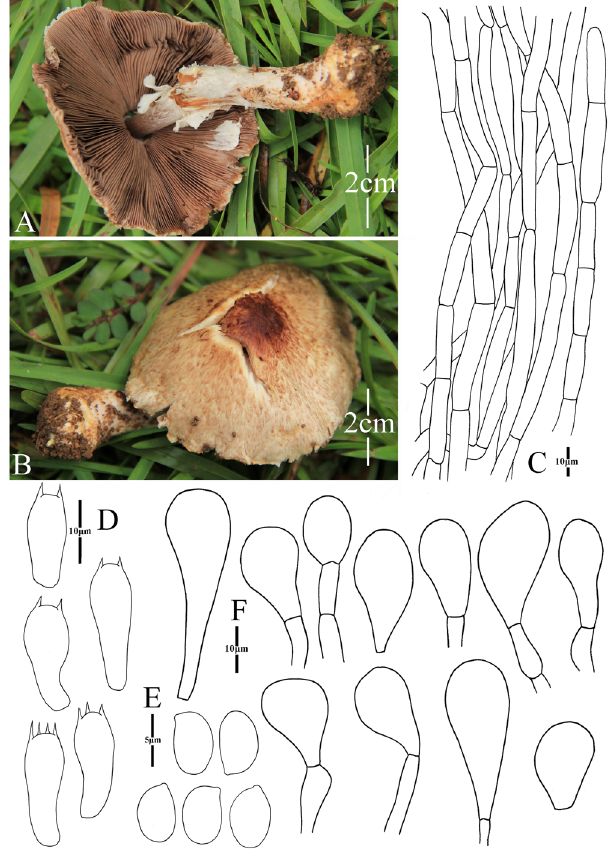
Figure 18. Morphology of Agaricus rufuspileus ( ZRL2014140 , holotype), ( A , B ): Basidiome in field ( ZRL2014140 ), ( C ): Pileipellis hyphae, ( D ): Basidia, ( E ): Basidiospores, and ( F ):